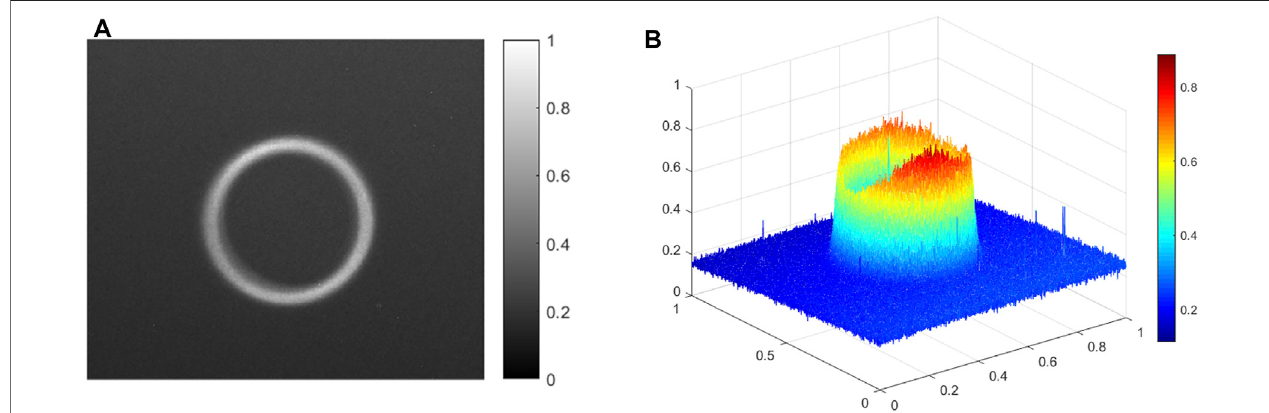
FIGURE 7 | Establishment of a polar coordinate system with the center of the far- fi eld pattern of the condenser as the origin (the circle region with the redlineistheidealfar- fi eldpatternofthecondenser,andtheinsetattheupper right shows the intensity pro fi le along the white line).